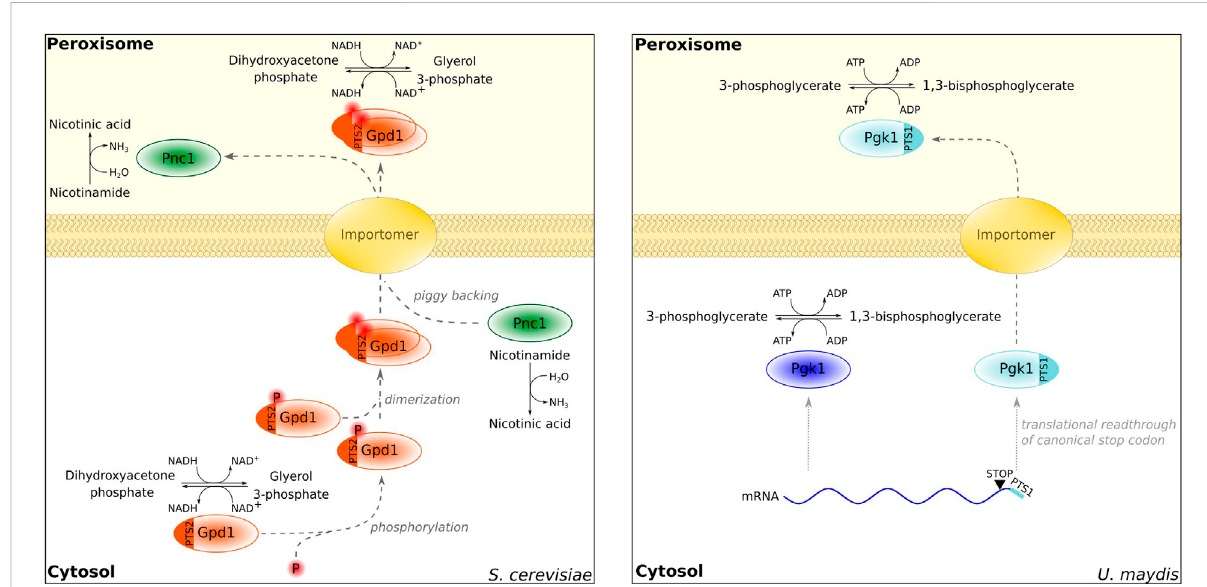
FIGURE 1 Examples of proteins localized in the cytosol and peroxisomes. Gpd1 distribution is controlled by phosphorylation [left; Jung et al. (2010)]. In addition,Gpd1regulatesthesortingofPnc1 via piggybacking(Effelsbergetal.(2015),Kumaretal. (2016),Al-Saryietal. (2017b)).Anextendedisoform of Pgk1 derived from translational readthrough is localized in peroxisomes in Ustilago maydis [right; Freitag et al.